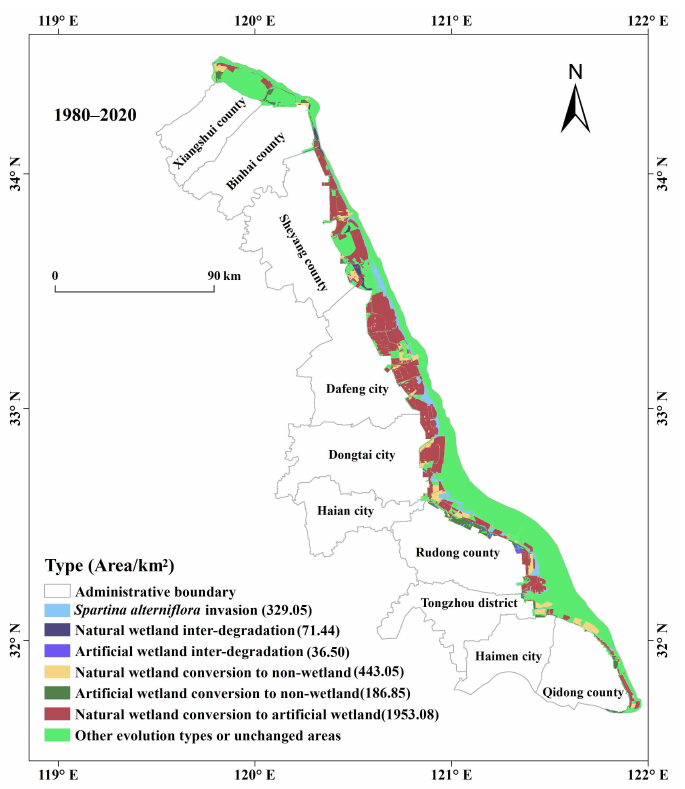
Figure 5. Spatial distribution of coastal wetland degradation types from 1980 to